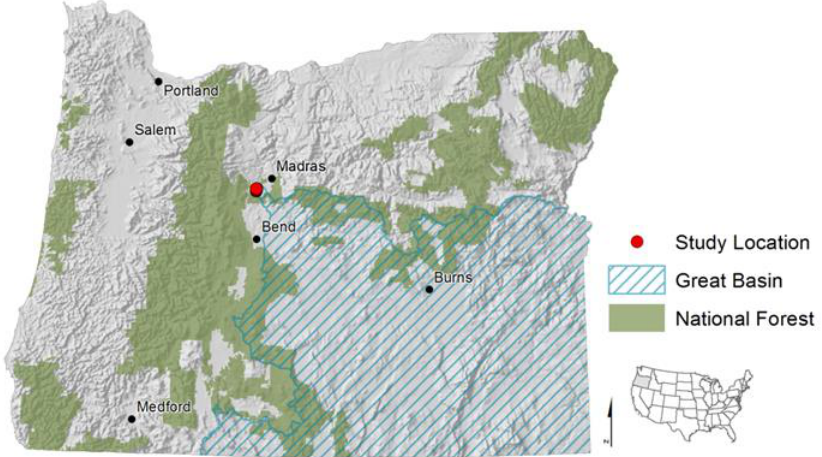
Figure 1. Location of the study area in central Oregon relative to national forestlands and the northwestern edge of the Great Basin as mapped by the Great Basin Restoration Initiative [41].